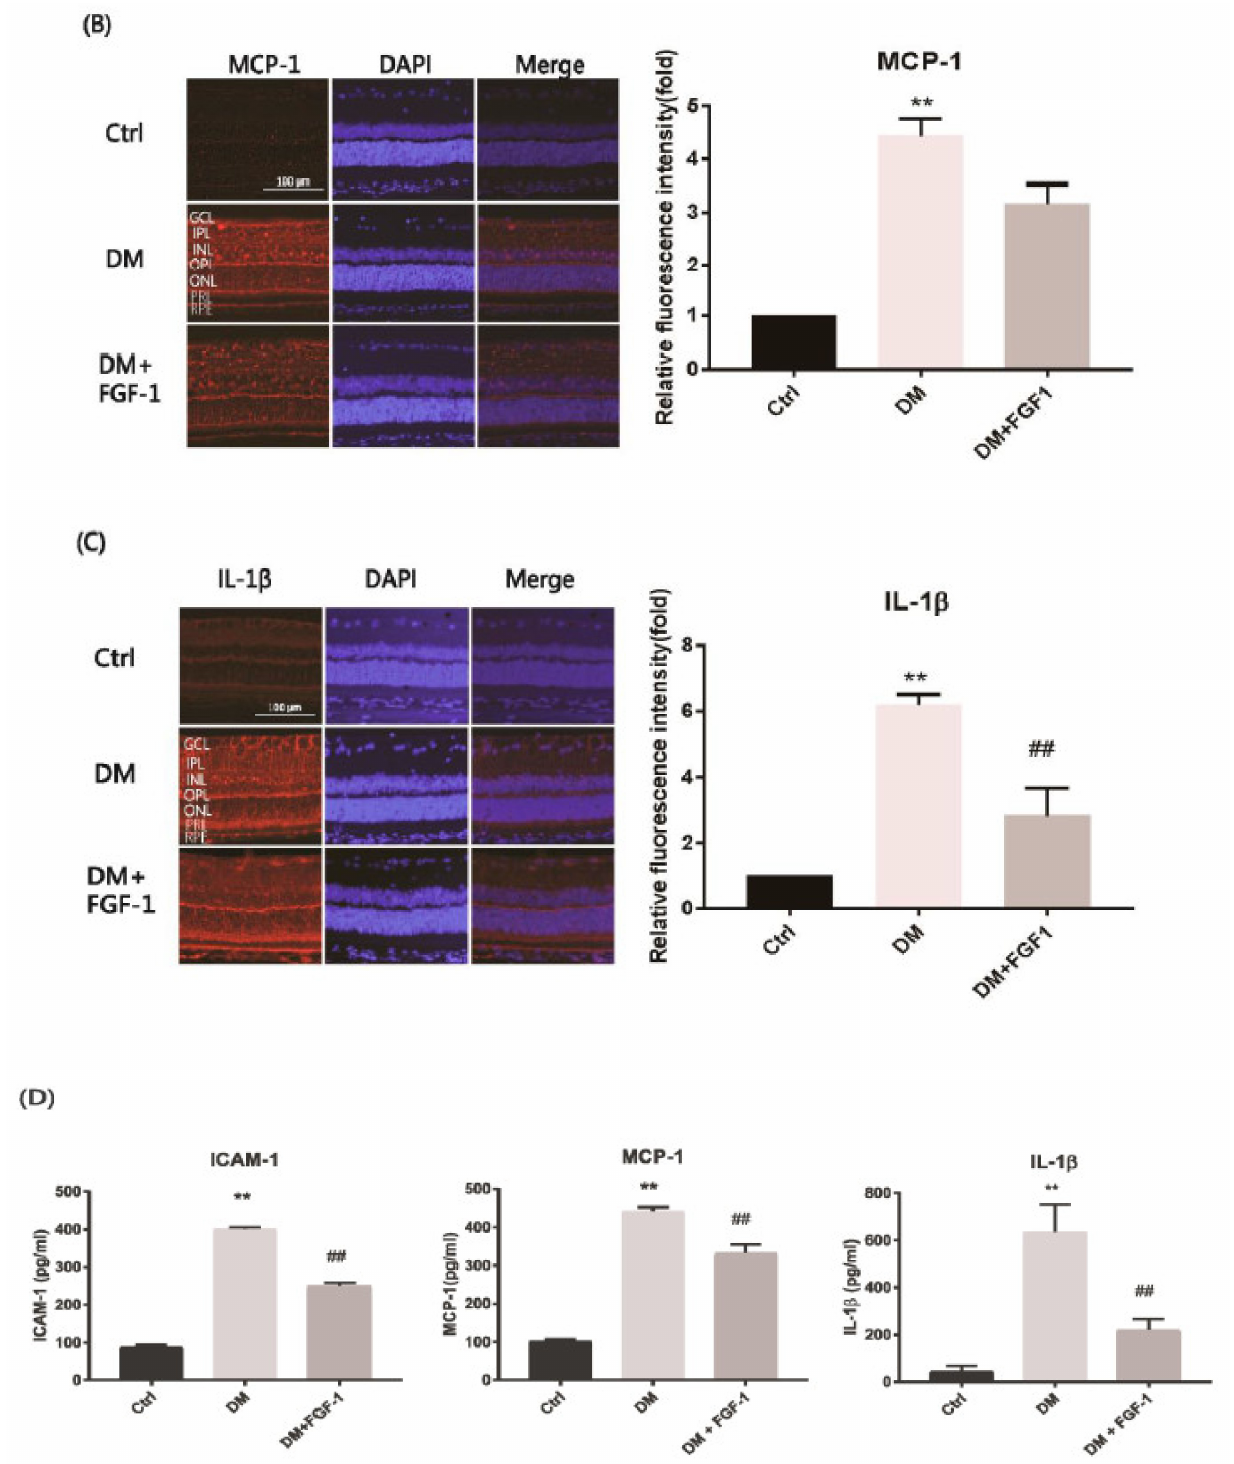
Figure 3. FGF-1 treatment attenuated inflammatory mediators in rats. Retinal sections were collected from 12-week-old SD rats in each group. Immunofluorescence images of inflammatory mediators ( A ) ICAM-1, ( B ) MCP-1, and ( C ) IL-1 β in retinal tissue. The relative densities of immunofluorescence images were quantified using ImageJ software and are presented in bar graphs ( n = 4 eyes in each group). ( D ) Aqueous humor was collected from the rat eyeballs. ICAM-1, MCP-1, and IL-1 β protein levels were measured in each group using ELISA. Each assay was repeated three times ( n = 4 eyes in each group). All data are presented as mean ± standard deviation; ** p < 0.01 compared with the control group; # p < 0.05, ## p < 0.01 compared with the diabetes group. DAPI, 4 (cid:48) ,6-diamidino-2-phenylindole; Ctrl, control group; DM, STZ-induced diabetic rat group; DM + FGF-1, fibroblast growth factor type 1 treatment